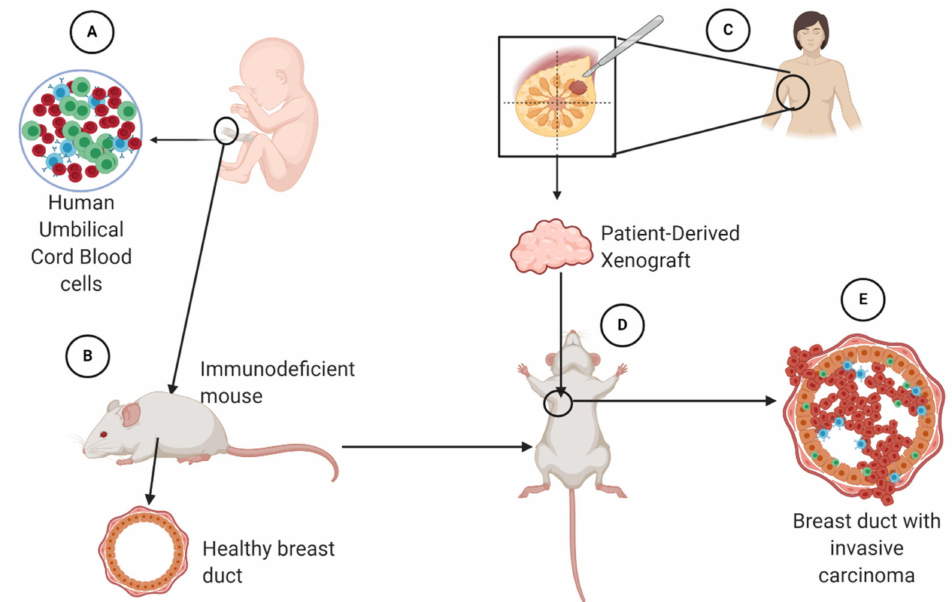
Figure 6. Designing a humanized mouse model using umbilical cord blood cells ( A ). These cells are introduced into a healthy immunodeficient mouse ( B ), so that it will develop human immune cells. Human xenografts from triple-negative breast cancer (TNBC) patients can be obtained ( C ) and transplanted ( D ) into the mouse model at the mammary site. The goal is for the mouse to develop TNBC ( E ) so that it is possible to observe an interaction between human cancer cells and human lymphocytes in this